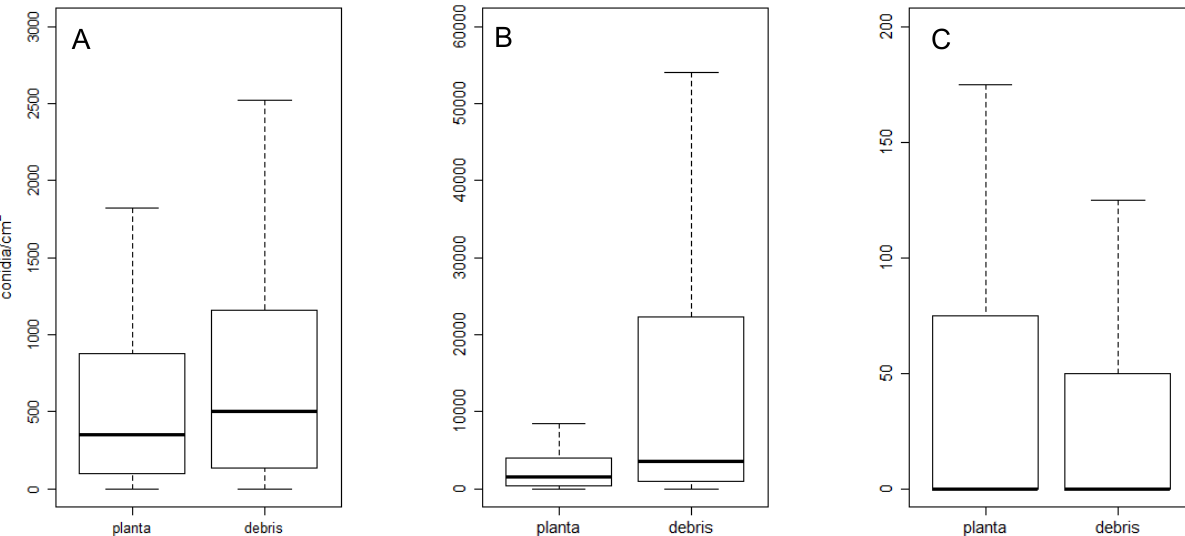
Figure 2. Boxplots of the distributions of the numbers of conidia sampled per cm 2 of microscope slide spore trap surface, from symptomatic plants or pruning debris, found during 30 2-week sampling periods, for Diplodia (A), Lasiodiplodia (B), or Neofusicoccum (C). Boxes include the 2nd and 3rd quartiles, the dotted line is the median, and whiskers extend to minimum and maximum values. Outliers are not